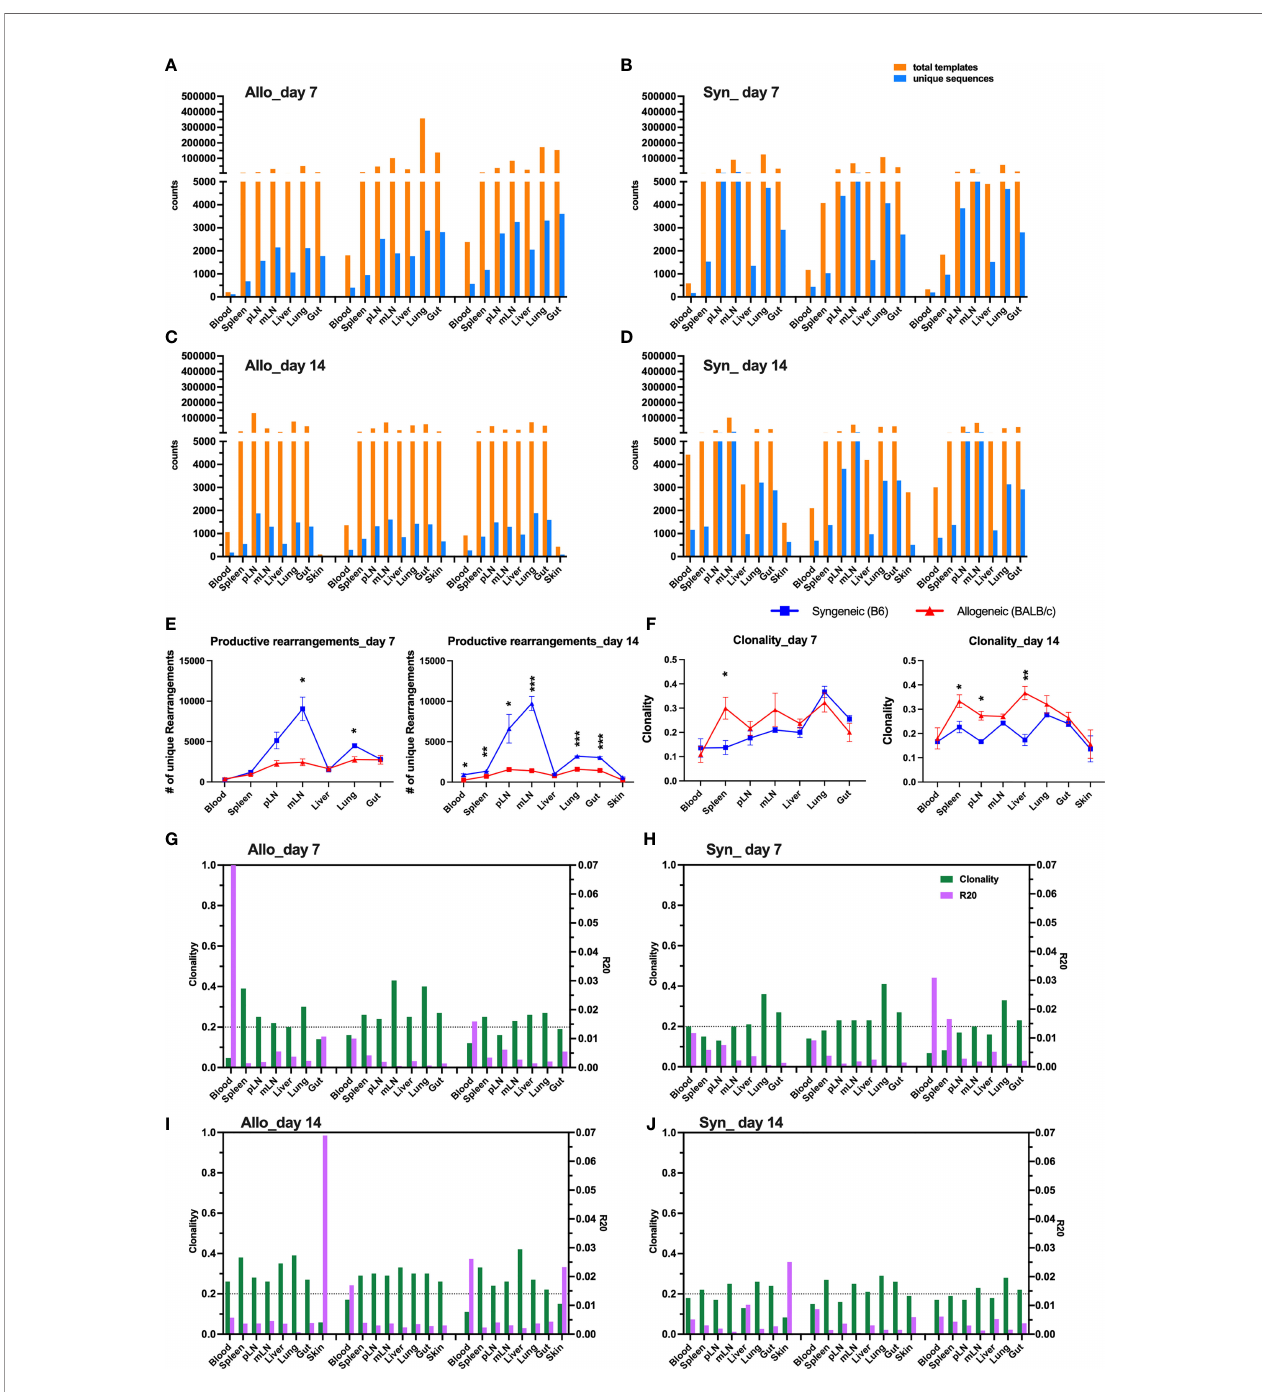
FIGURE 1 | Clonal expansion of T cells in allogeneic recipient after BMT. Rag1 -/- BALB/c or Rag1 -/- B6 mice were conditioned with total body irradiation (TBI) administered 550 cGy (BALB/c) or 750 cGy (B6) using an X-RAD 320 X-ray Irradiator. Puri fi ed T cells (1 × 10 6 ) from B6 mice together with bone marrow cells (5 × 10 6 ) isolated form Rag1 -/- B6 were i.v. injected into these recipient mice within 24 h after TBI. On day 7 and day 14, gDNA were acquired from relevant tissues from individual recipient mice for TCR b sequencing. Unique sequence was de fi ned by CDR3 AA + V gene + J gene. The total counts of productive templates and number of unique productive sequences in each organ of individual mouse were computed and showed in bar group (A – D) . Data from three replicate mice were pooled for showing number of unique sequences across tissue sites (E) . Repertoire diversity was analyzed by calculating clonality (entropy divided by maximum possible entropy) and R20 (the minimum clone fraction required to capture 20% of overall clone frequency) in each tissue of individual mice (G – J) . The clonality data pooled from three replicate mice were shown (F) . Clonality ranges from 0 to 1 where higher scores indicate greater clonal expansion and lower repertoire diversity. R20 < 0.2 indicates non-uniform clone frequency, with extremely low values representing presence of a small number of highly dominant high-frequency clones. *p < 0.05, **p < 0.01, ***p <